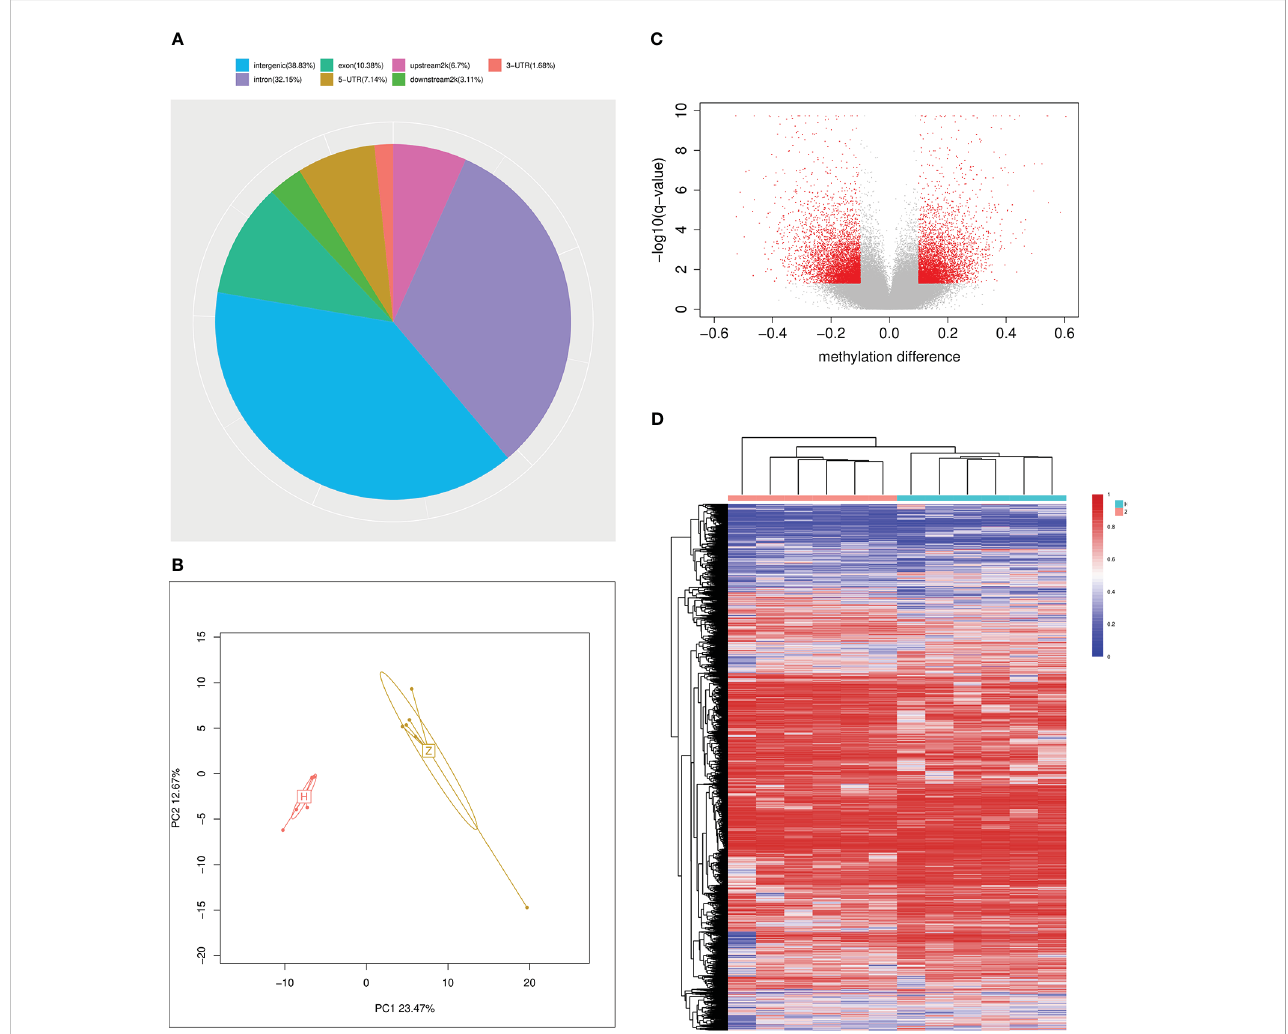
FIGURE 2 Summary of DMRs between Han and Tibetan T2D patients (A) The overall distribution of DMRs. (B) The principal component analysis plot using the differential methylated CpG sites between Han and Tibetans. (C) Volcano plot of methylation difference between Han and Tibetans. A total of 4787 CpG sites hypermethylated in Tibetans was represented by red point in the right side. A total of 5178 CpG sites hypomethylated in Tibetans was represented by red point in the left side. (D) Heatmap clustering analysis of DMRs of different gene functional regions. Highly methylated sites are shown in red and sparsely methylated sites are shown in blue. In addition, the pink clusters represent Tibetans and the blue clusters represent Han Chinese. H: Han, Z: Tibetan.